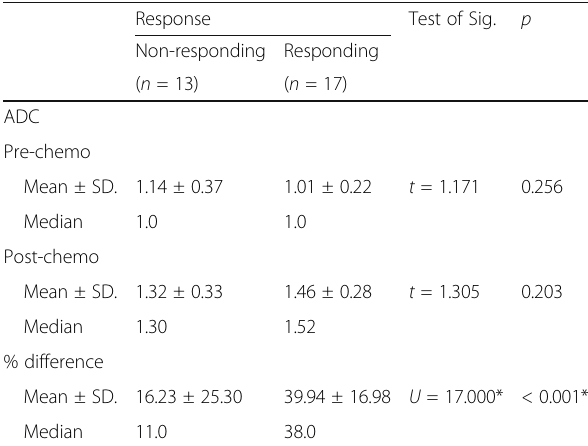
Table 3 Relation between response with ADC and % difference of size regression Response Test of Sig.